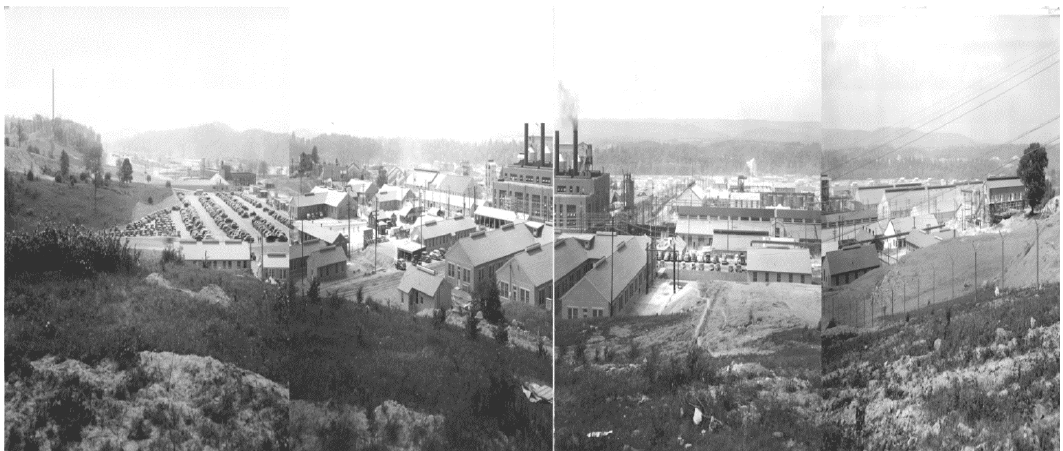
Figure 1. Radford Ordnance Works (Radford Army Ammunition Plant), 1941. [11].